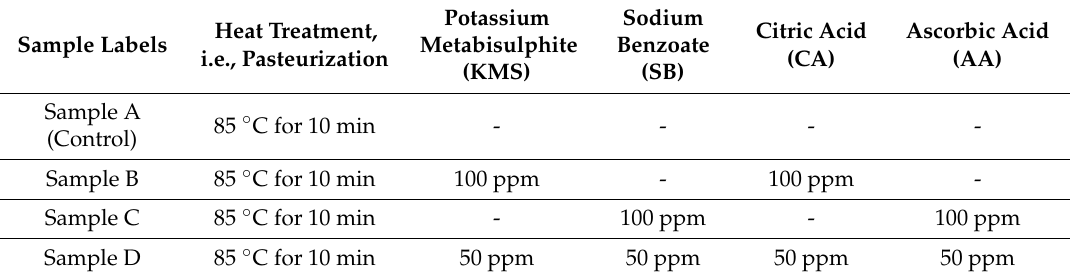
Table 1. Labeling of samples showing doseage of heat treatment and concentrations of preservatives.